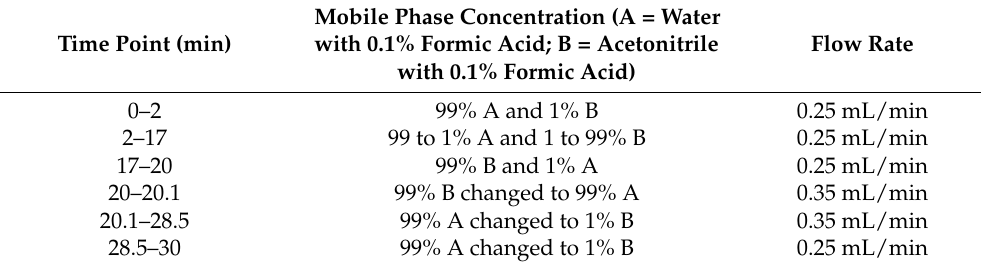
Table 5. The mobile phase gradient